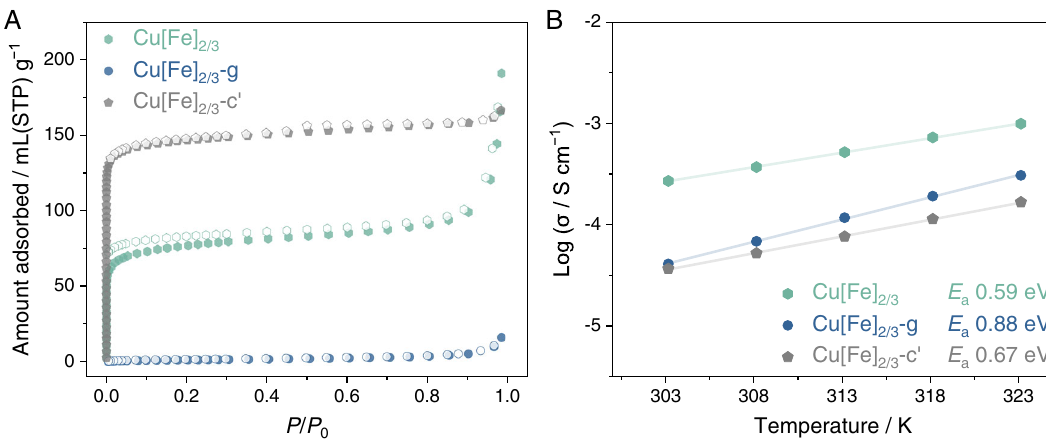
Fig. 3 N 2 adsorption and electronic conductivity. A N 2 adsorption isotherms at 77 K of Cu[Fe] 2/3 (green), Cu[Fe] 2/3 -g (blue), and Cu[Fe] 2/3 -c' (grey). Adsorption and desorption processes are represented by fi lled and hollow symbols, respectively. B Electronic conductivities of Cu[Fe] 2/3 , Cu[Fe] 2/3 -g, and Cu[Fe] 2/3 -c' measured in an Ar atmosphere. Source data are provided as a Source Data fi le. NATURE COMMUNICATIONS| (2022) 13:4023